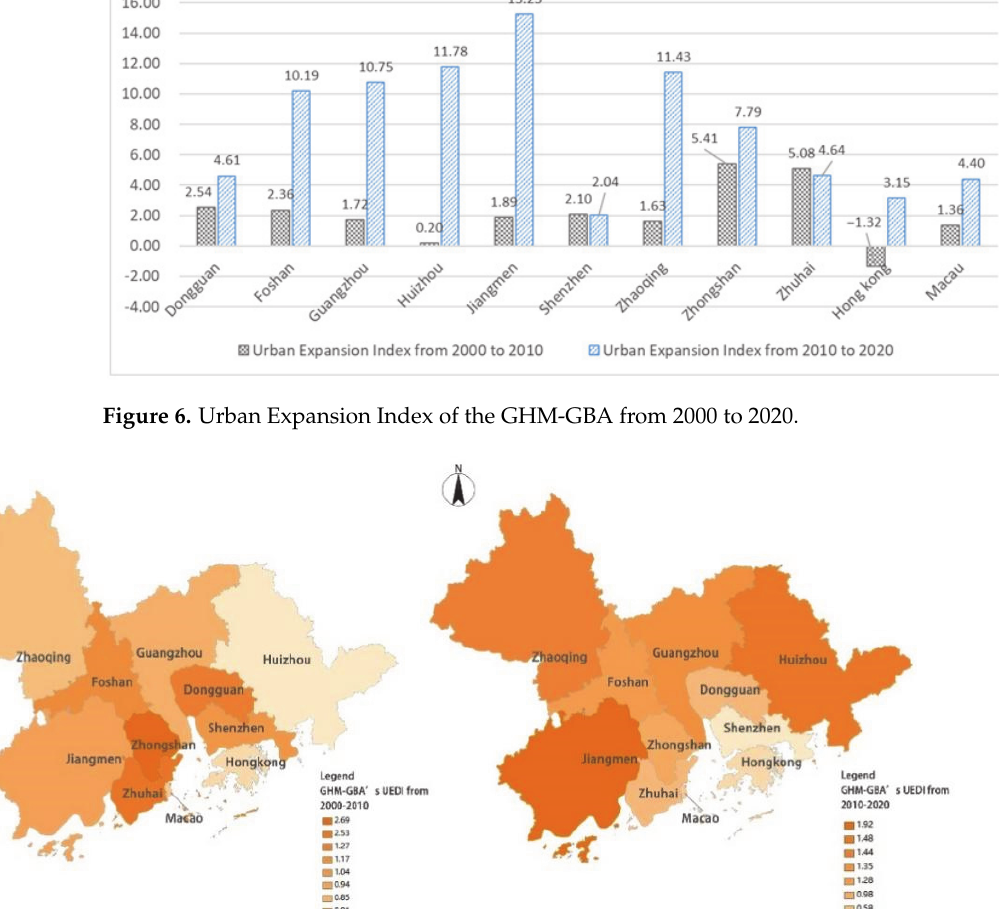
Table 3. Land demand and formula.